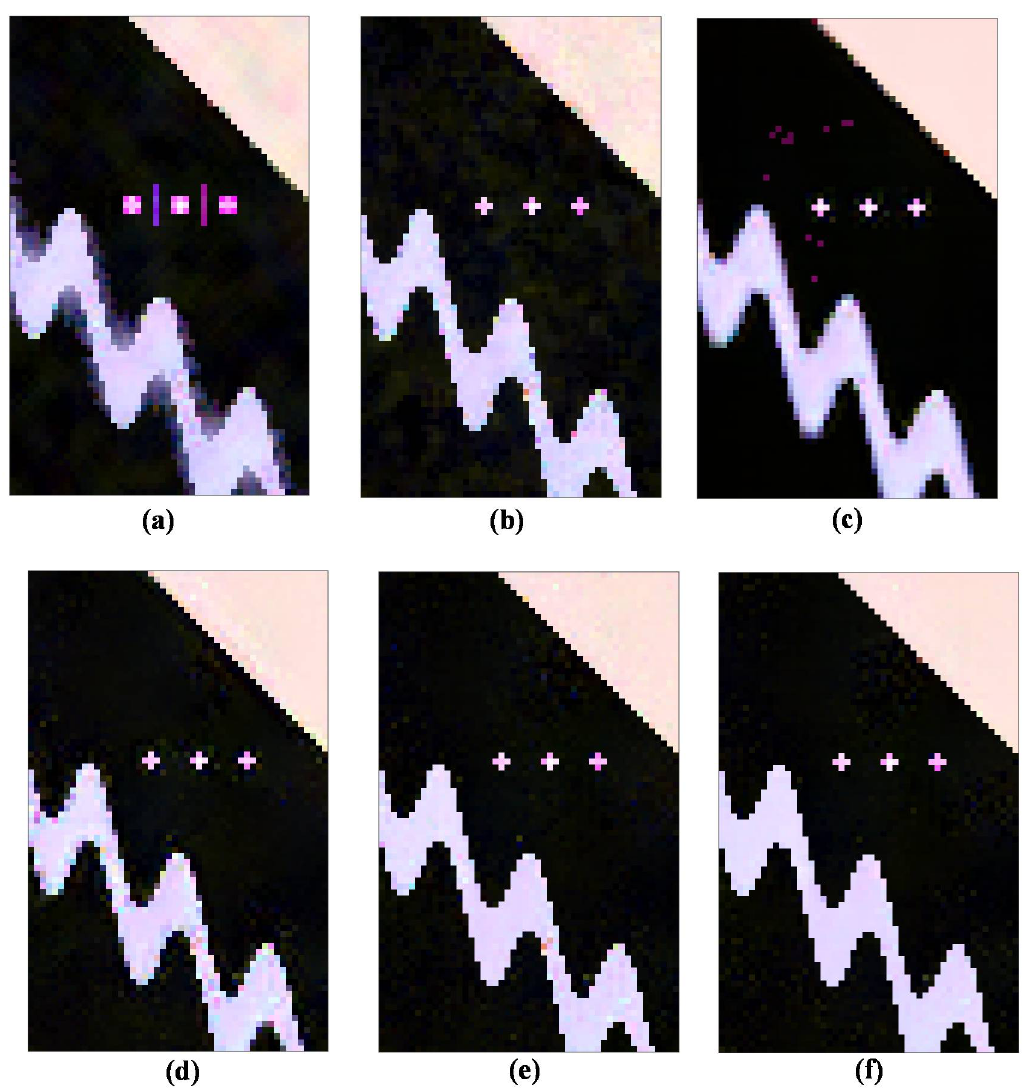
Figure 5. Denoising results of different methods for simulated PolSAR dataset. ( a ) Refined Lee filter. ( b ) IDAN filter. ( c ) Pretest filter. ( d ) NL-SAR filter. ( e ) The proposed ANLM with single threshold h 0.50 . ( f ) The proposed ANLM with optimal threshold.